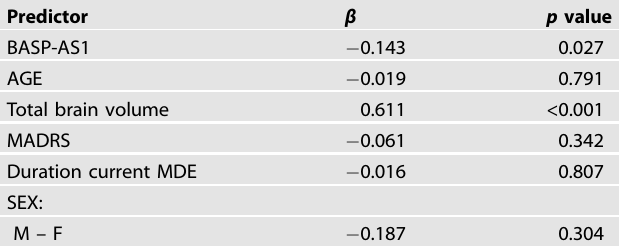
Table 4. Association between BASP1-AS1 expression and right hippocampal tail volumes in MDD.